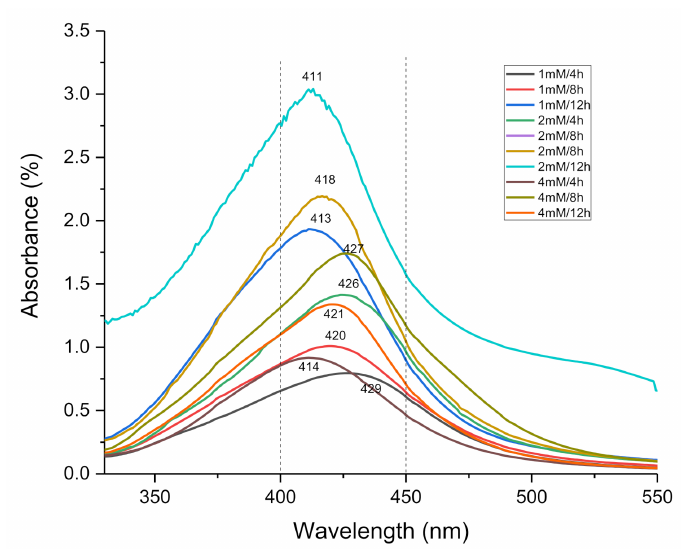
Figure 2. UV-VIS absorbance spectrum of the AgNPs synthetized by pecan nut shell extract at different